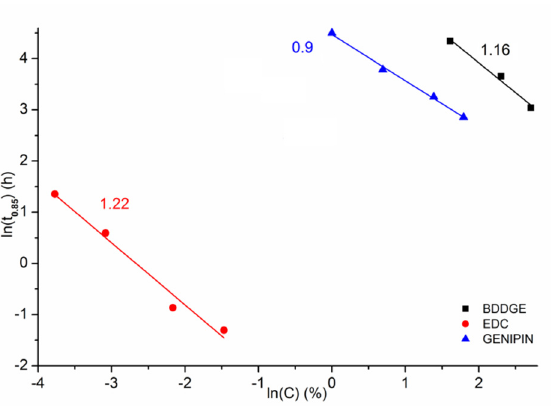
Figure 7. Graph combining t 0.85 vs. C for all experiments with slope values.